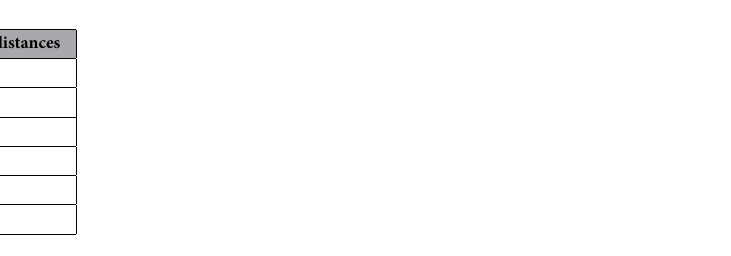
Table 3. Nei genetic distances among different pairwise ethnic